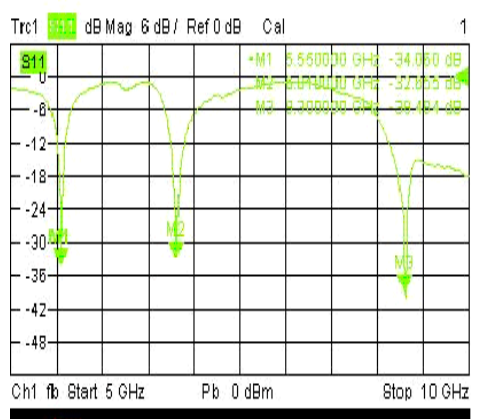
Figure 6: a. Return Loss of experimentally measured proposed Antenna: dual layer printed Antenna integarted with FSS rings & DGS.